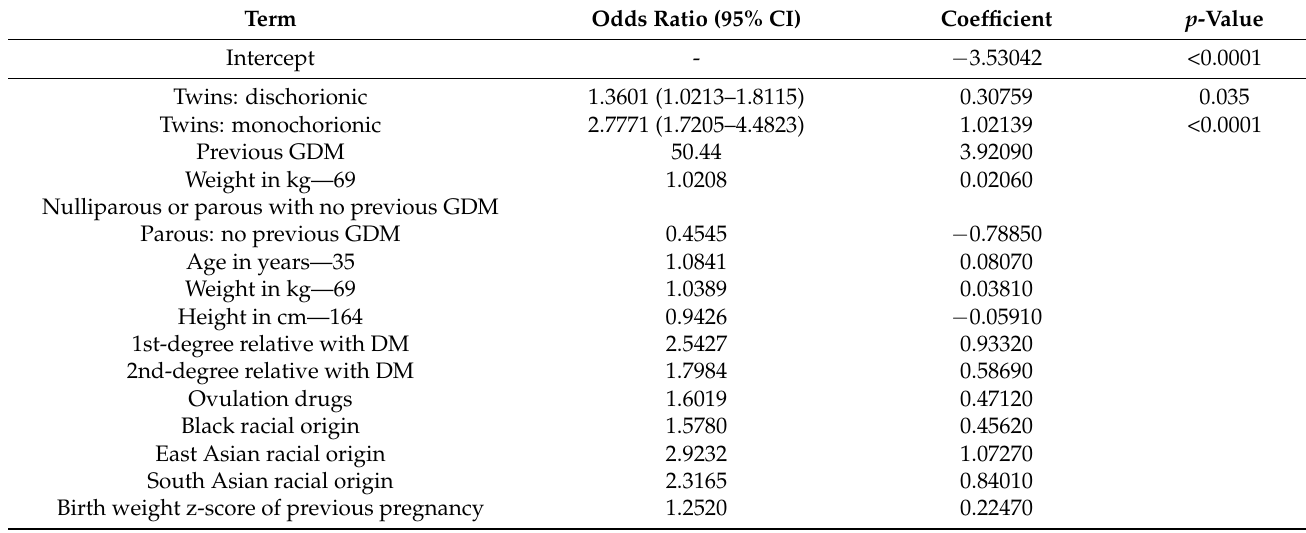
Table 2. Logistic regression model for the prediction of gestational diabetes mellitus from maternal characteristics and elements of medical history. Confidence limits are provided only for the twin pregnancies because the odds ratio for the other terms are identical to those of our previous publication in singleton pregnancies